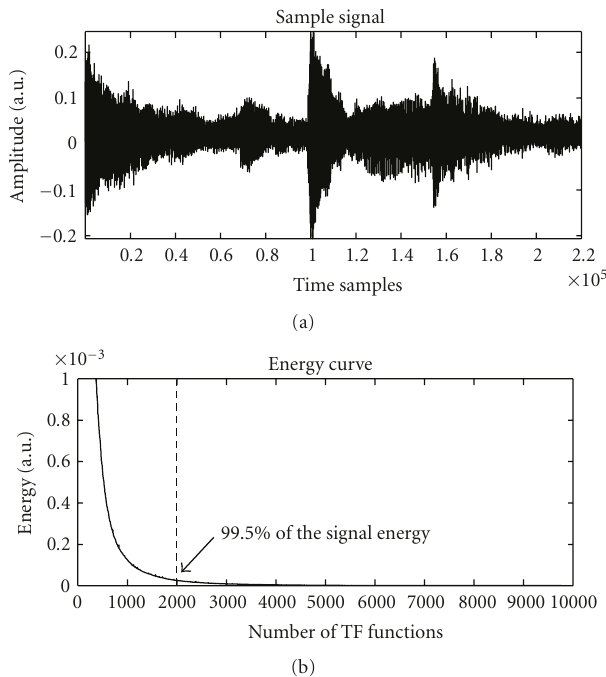
Figure 4: Energy cuto ff of the sample signal in panel 1. a.u.: arbitrary